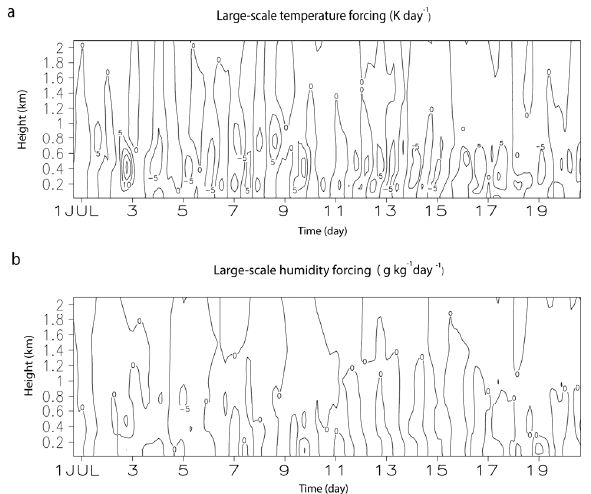
Fig. 3. Time series of surface sensible (SH) and latent (LH) heat fluxes (Wm − 2 ) (a) for the CSRM run and (b) time series of LH surface fluxes for the CSRM-LH